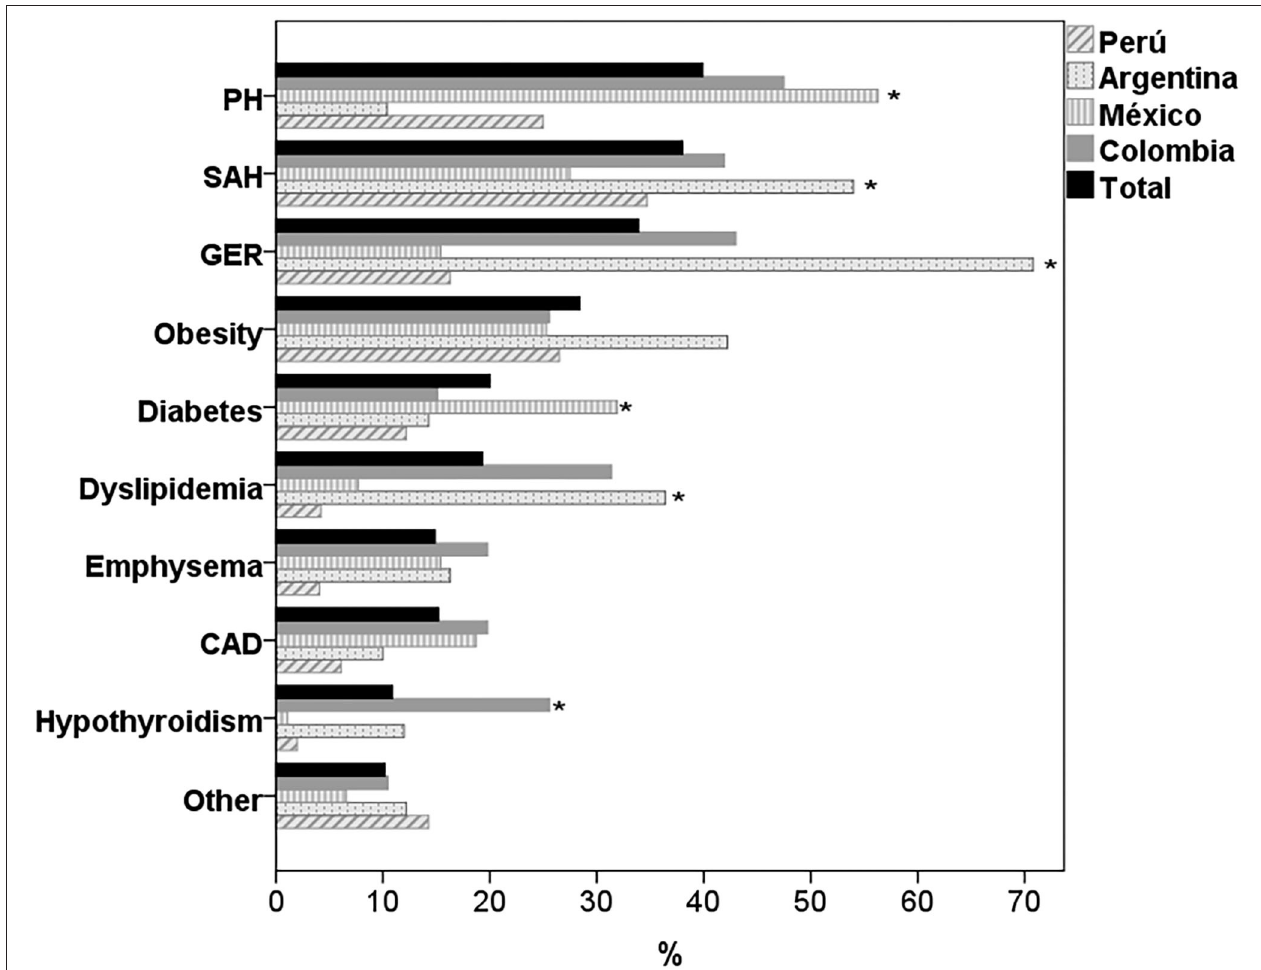
FIGURE 1 | Comorbidities in patients with IPF by country. PH, pulmonary hypertension; SAH, systemic arterial hypertension; GER, gastroesophageal reflux; CAD, coronary artery disease. * p < 0.05 for differences between